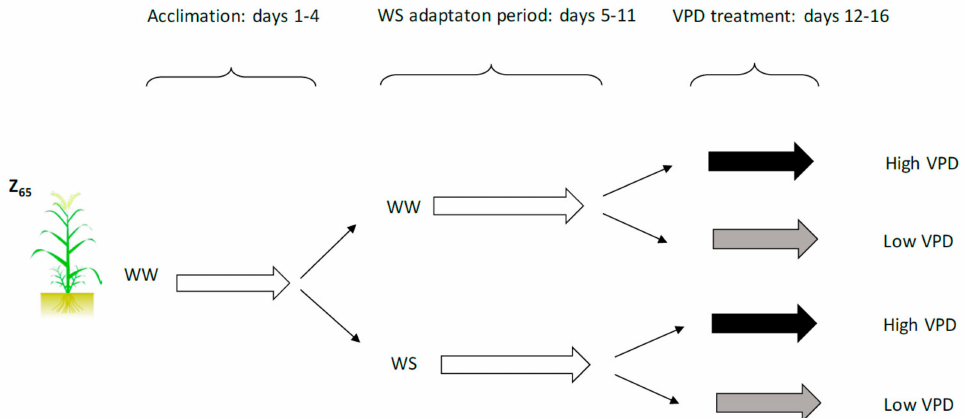
Figure 1. Experimental design on wheat plants exposed to different water irrigation (pot capacity- WW- versus 50% of pot capacity-WS) and ambient vapour pressure deficit (VPD; high 40 % RH versus low 80% RH). During acclimation (days 1–4) and WS adaptation (days 5–11) period plants were grown at 25/18 ◦ C RH and 1.27/0.42 Kpa VPD (corresponding to 60/80 % RH). During days 12–16 both control plants and water stressed plants were exposed to high (2.27/0.62 Kpa; 40/70 % RH) and low (1.01/0.36 Kpa; 70/80 % RH) VPD levels. During this final period 15N labelling was carried out in all